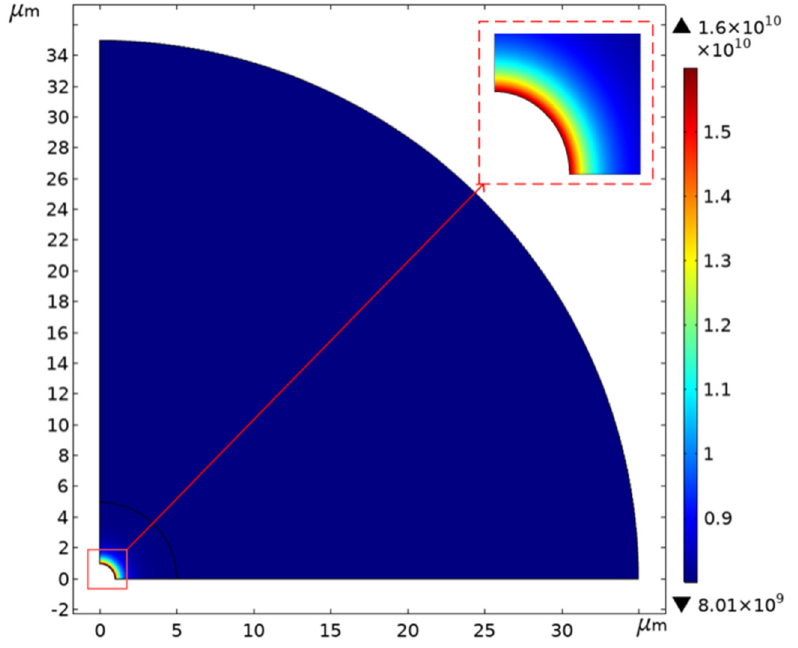
Figure 4. The simulation results of the stress distribution around the circular hole.